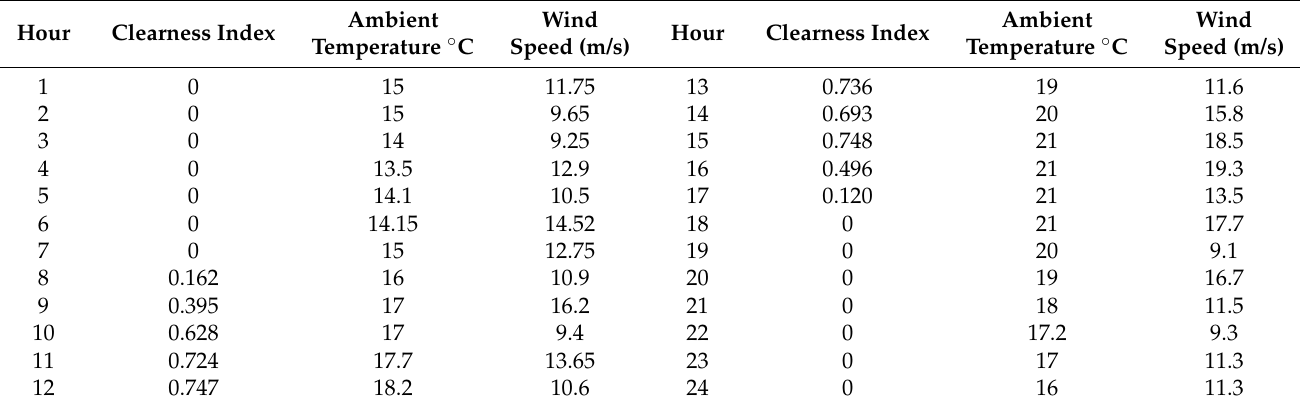
Table 23. Hourly clearness index, ambient temperature, and wind speed—case study 3.